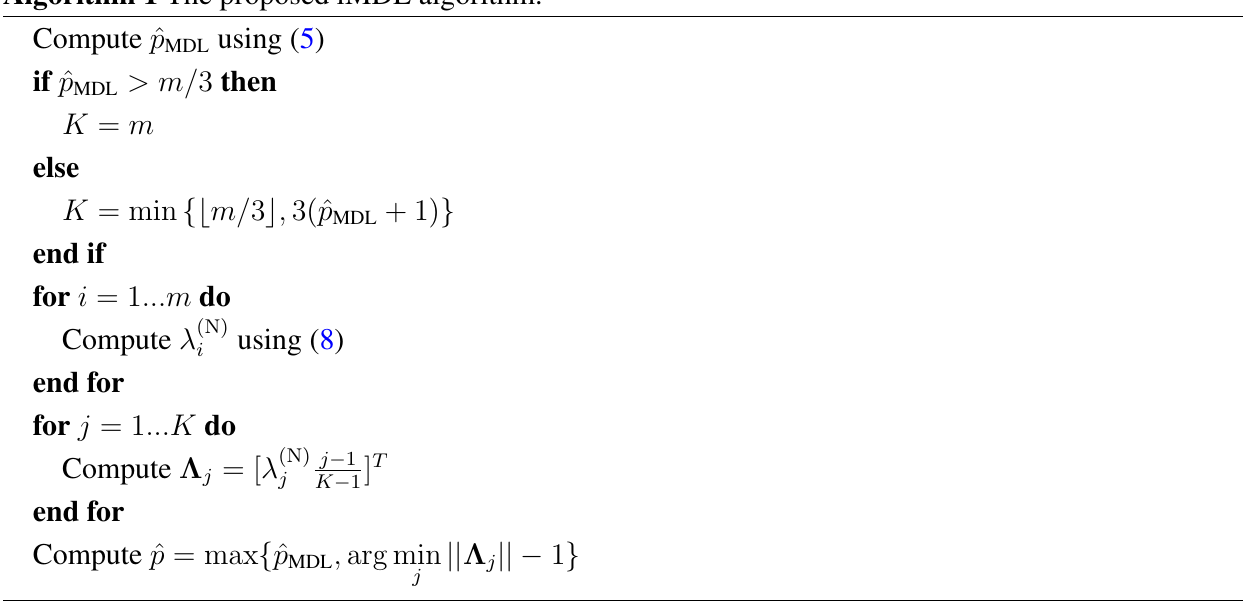
Algorithm 1 The proposed iMDL